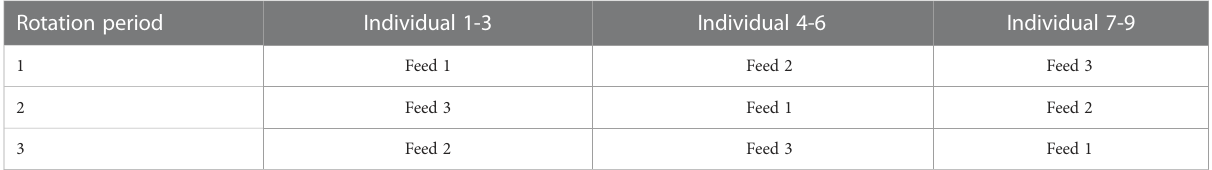
TABLE 3 Rotational feeding regime used in the